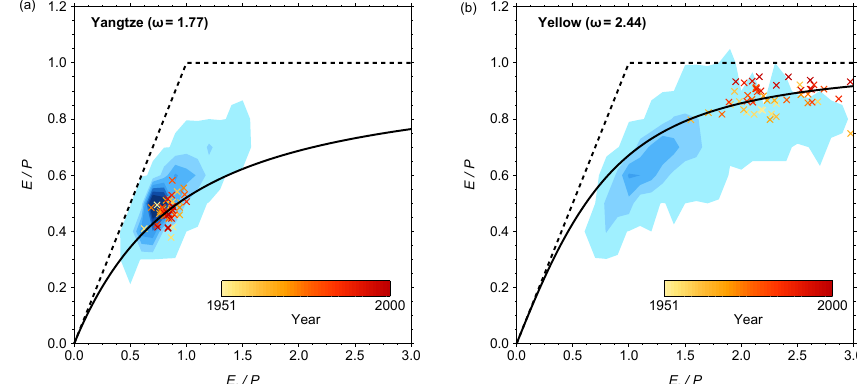
Figure 8. The evaporative index against aridity for the Yangtze (a) and Yellow (b) River catchments. The shaded blue regions represent the density of CMIP5 annual mean data for the 1951–2000 period, with darker shades meaning more data in a given region of the Budyko space. The symbols represent observed data, with darker shades for the more recent years. ω values are calculated for the 1951–2000 period using Eq. (5).